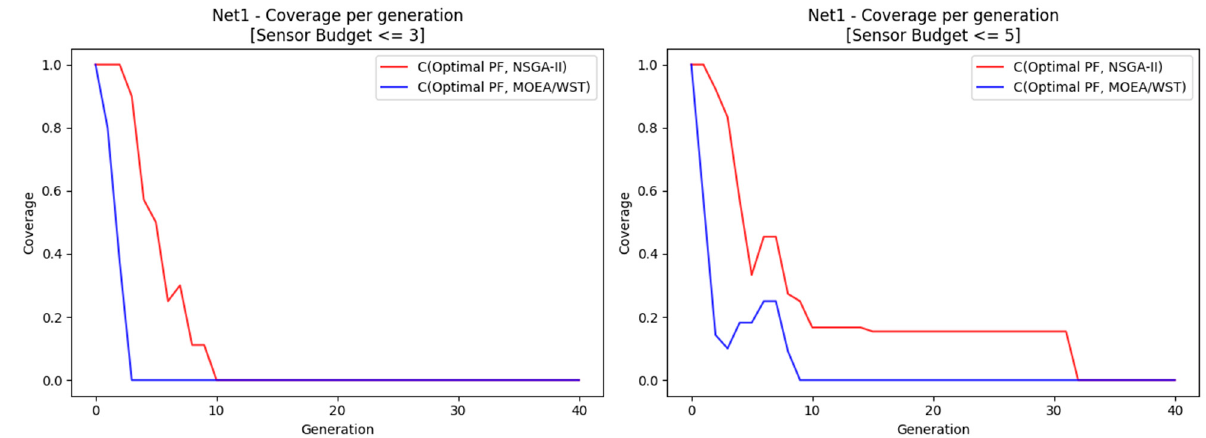
Figure 11. Coverage between the optimal Pareto frontier and the approximate one.